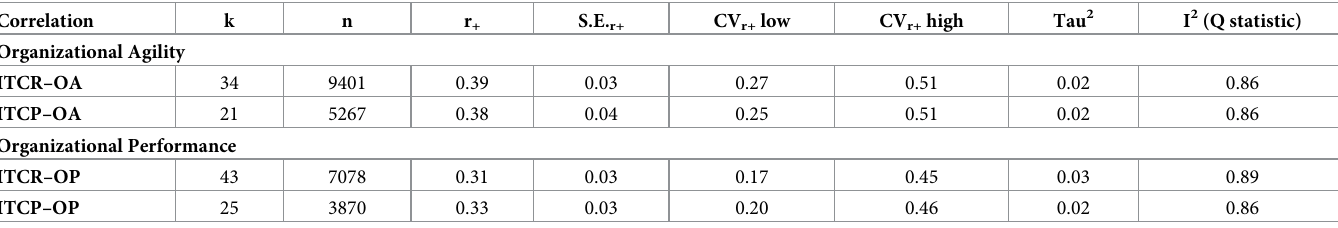
Table 4. Overview of